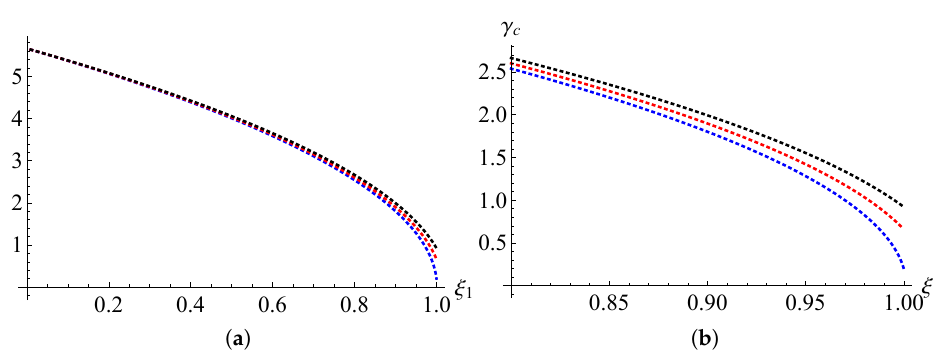
Figure 5. The critical velocity versus geometric parameter ξ when p = 0.04, α = 40, k s = 0.01. Black dotted line, red dotted line and blue dotted line denote the results for k = 3,2,1 mode, respectively. ( a ) full graph, ( b ) enlarger partial of full graph.